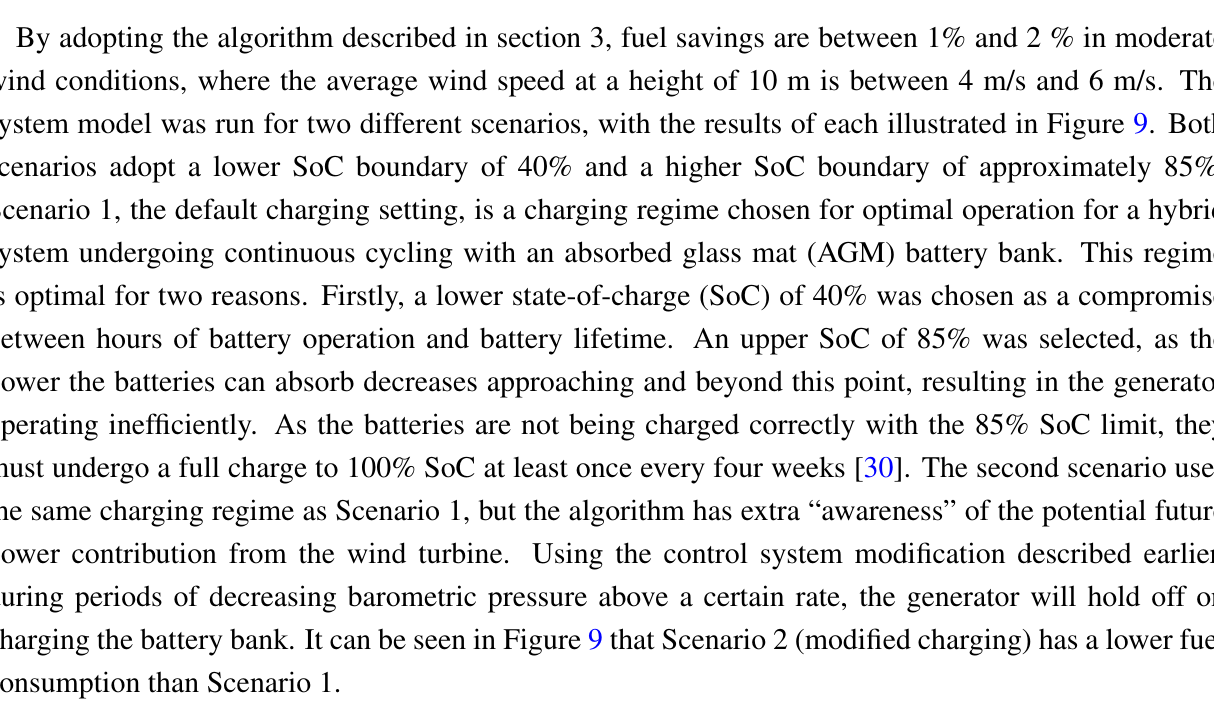
Figure 9. Fuel savings with and without the charging